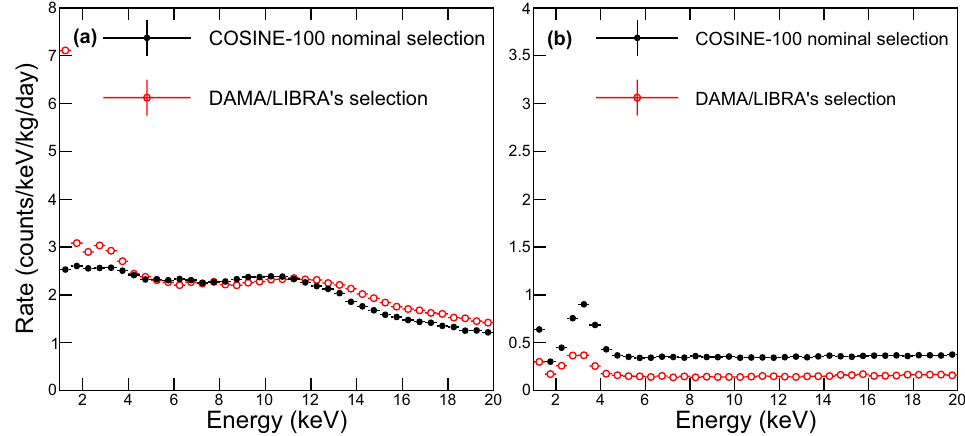
Figure 3. Low-energy spectra of a NaI(Tl) crystal in the COSINE-100 experiment. Energy spectra of one crystal (crystal 6) in COSINE-100 using nominal COSINE-100 event selection (black filled circles) and the DAMA/LIBRA’s event selection (red open circles) are presented for the single-hit events ( a ) and multiple-hit events ( b ). Here, selection efficiencies are corrected for proper comparison. Because we do not use the muon and LS detectors for the DAMA/LIBRA’s event selection, the COSINE-100 nominal analysis obtains significantly larger numbers of multiple-hit events. Due to the remnants of the PMT-induced events from the DAMA/ LIBRA’s event selection, a significant excess of the event rate below 2 keV in the single-hit events is